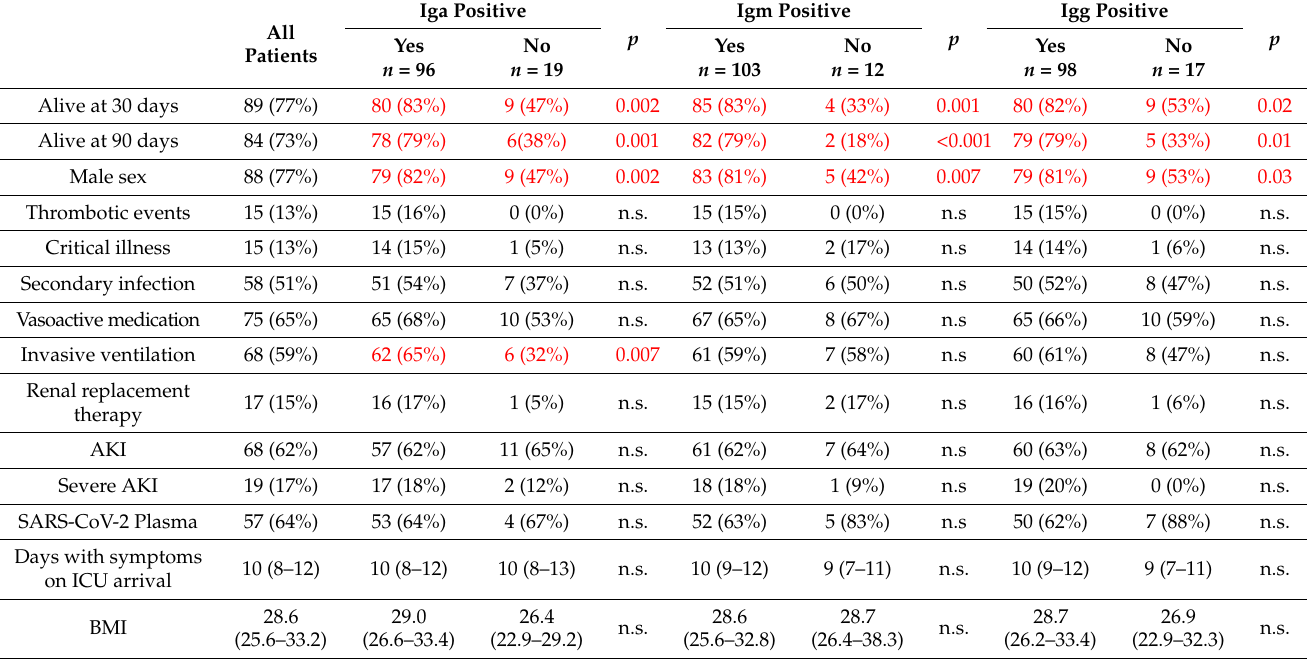
Table 2. Comparison between patients with or without anti-SARS-CoV-2